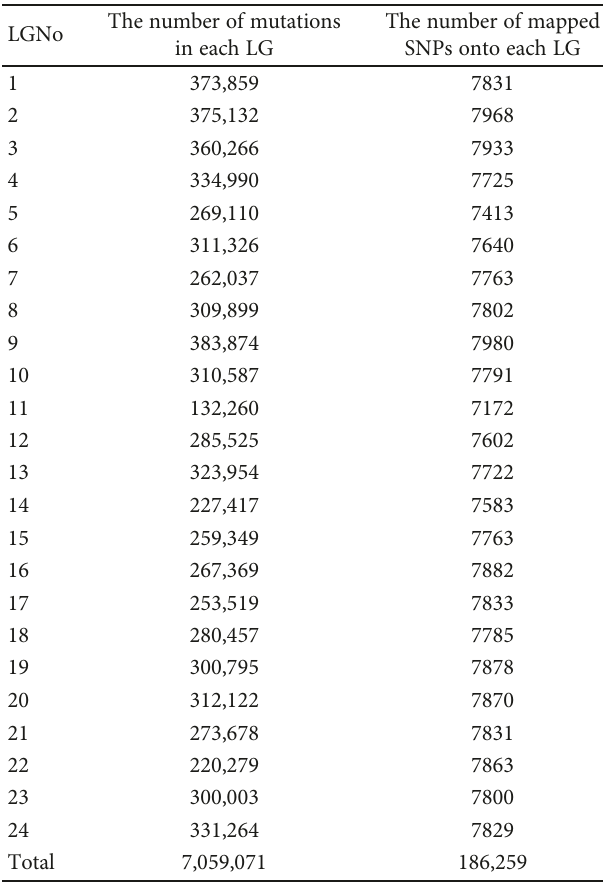
LGNo indicates the linkage group number; the number of mutations in each LG indicates the number of mutations found in each linkage group; and the number of mapped SNPs onto linkage group indicates the number of SNPs ordered onto each linkage